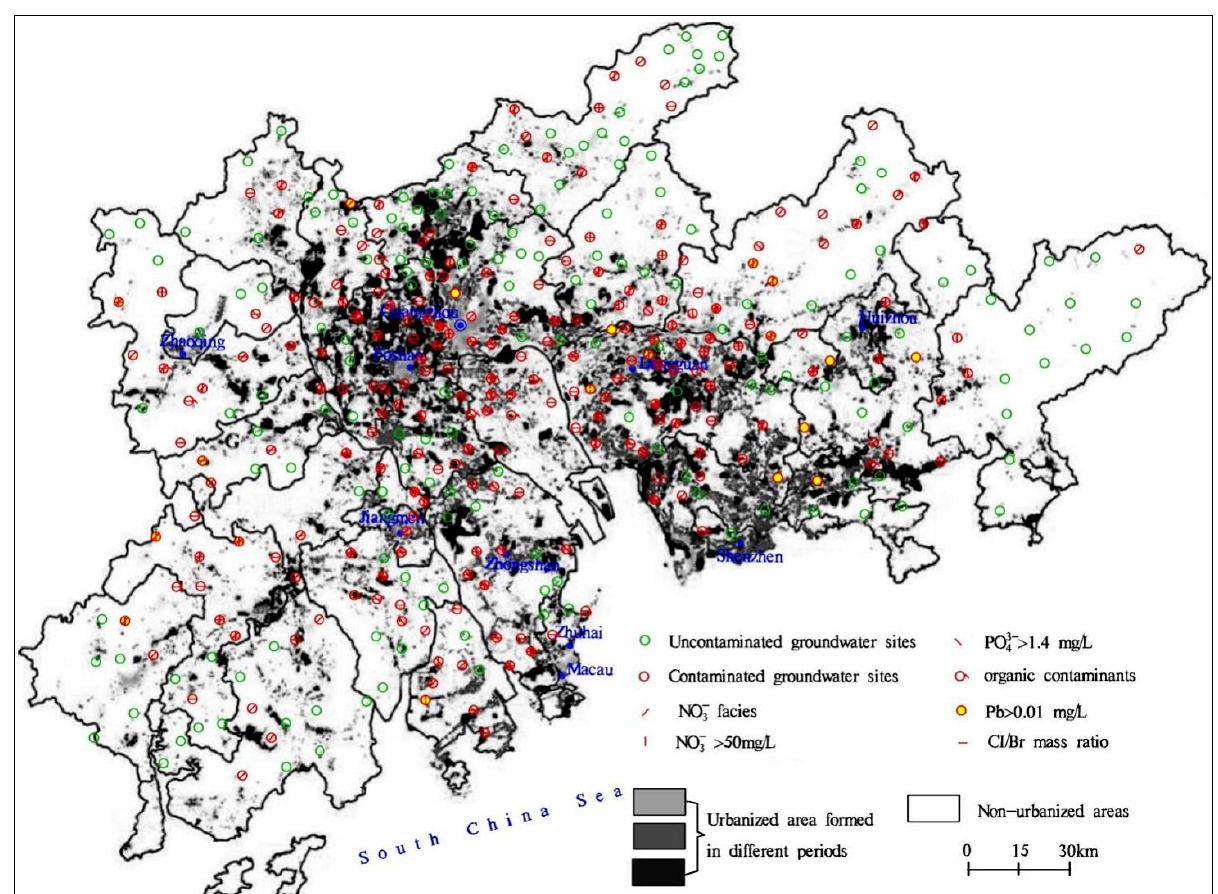
Figure 6. Spatial distribution of groundwater contamination in the Pearl River Delta.